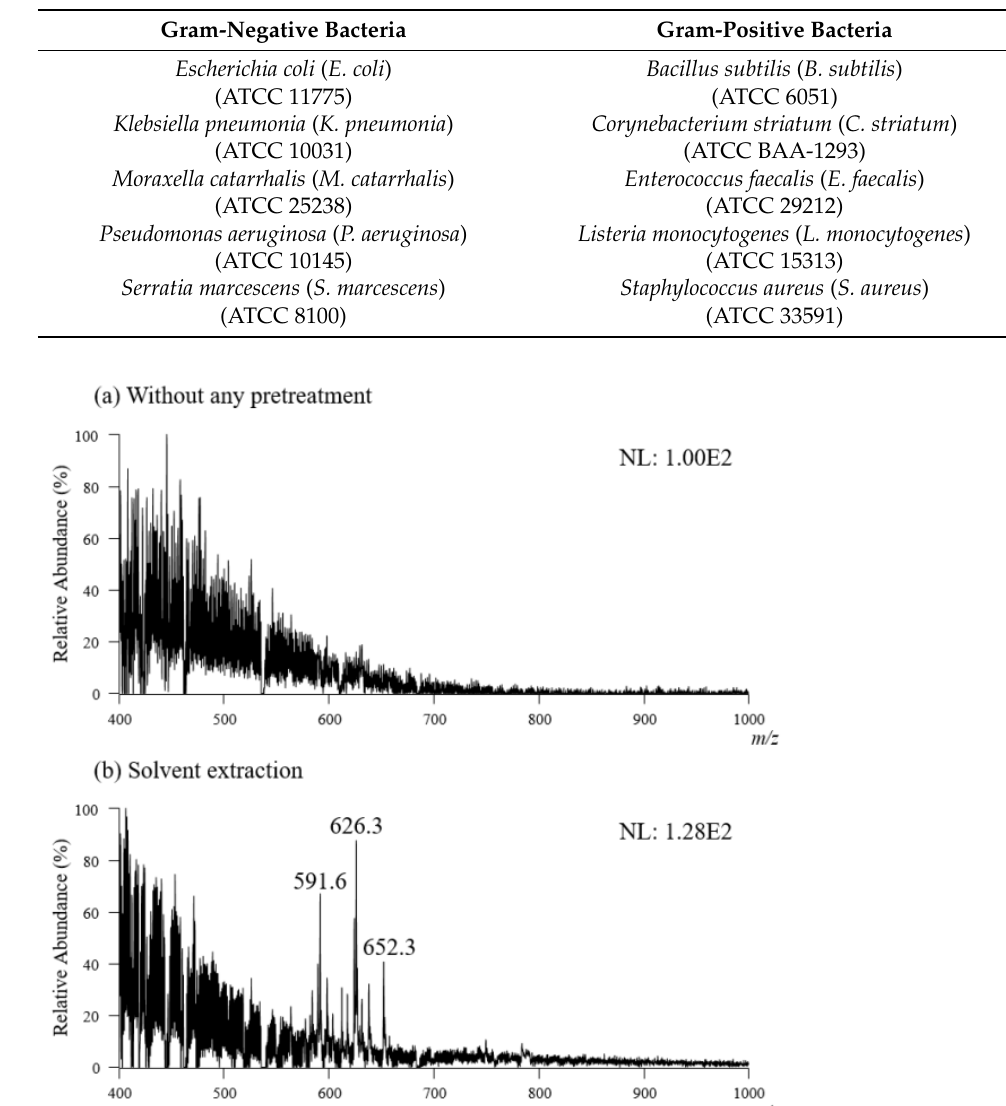
Table 1. Bacterial species tested in this study.